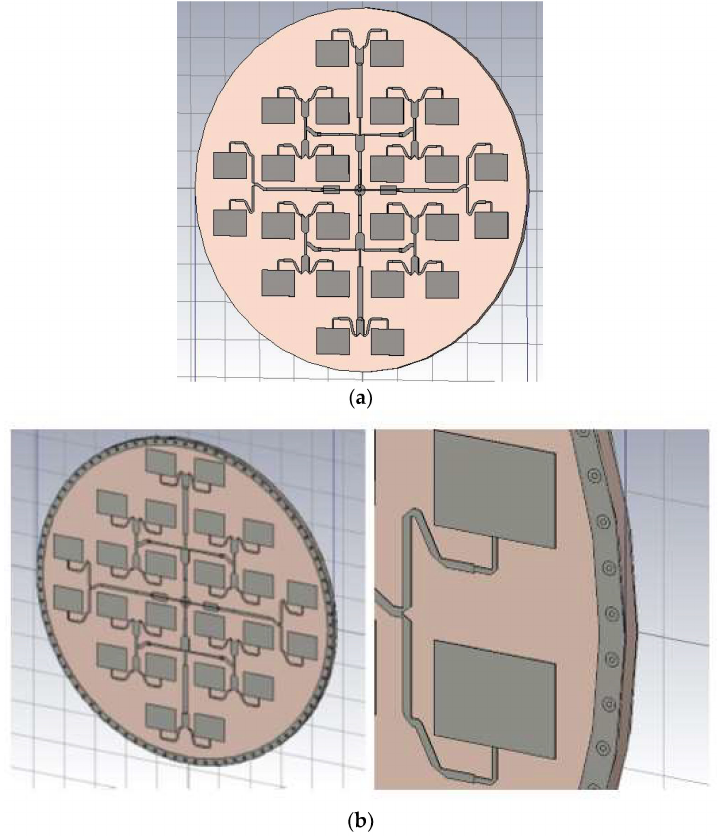
Figure 20. ( a ) CST MWS model of the microstrip antenna array with 24 elements, without SLL suppression ring. ( b ) CST MWS model of the microstrip antenna array with 24 elements, with an SLL suppression